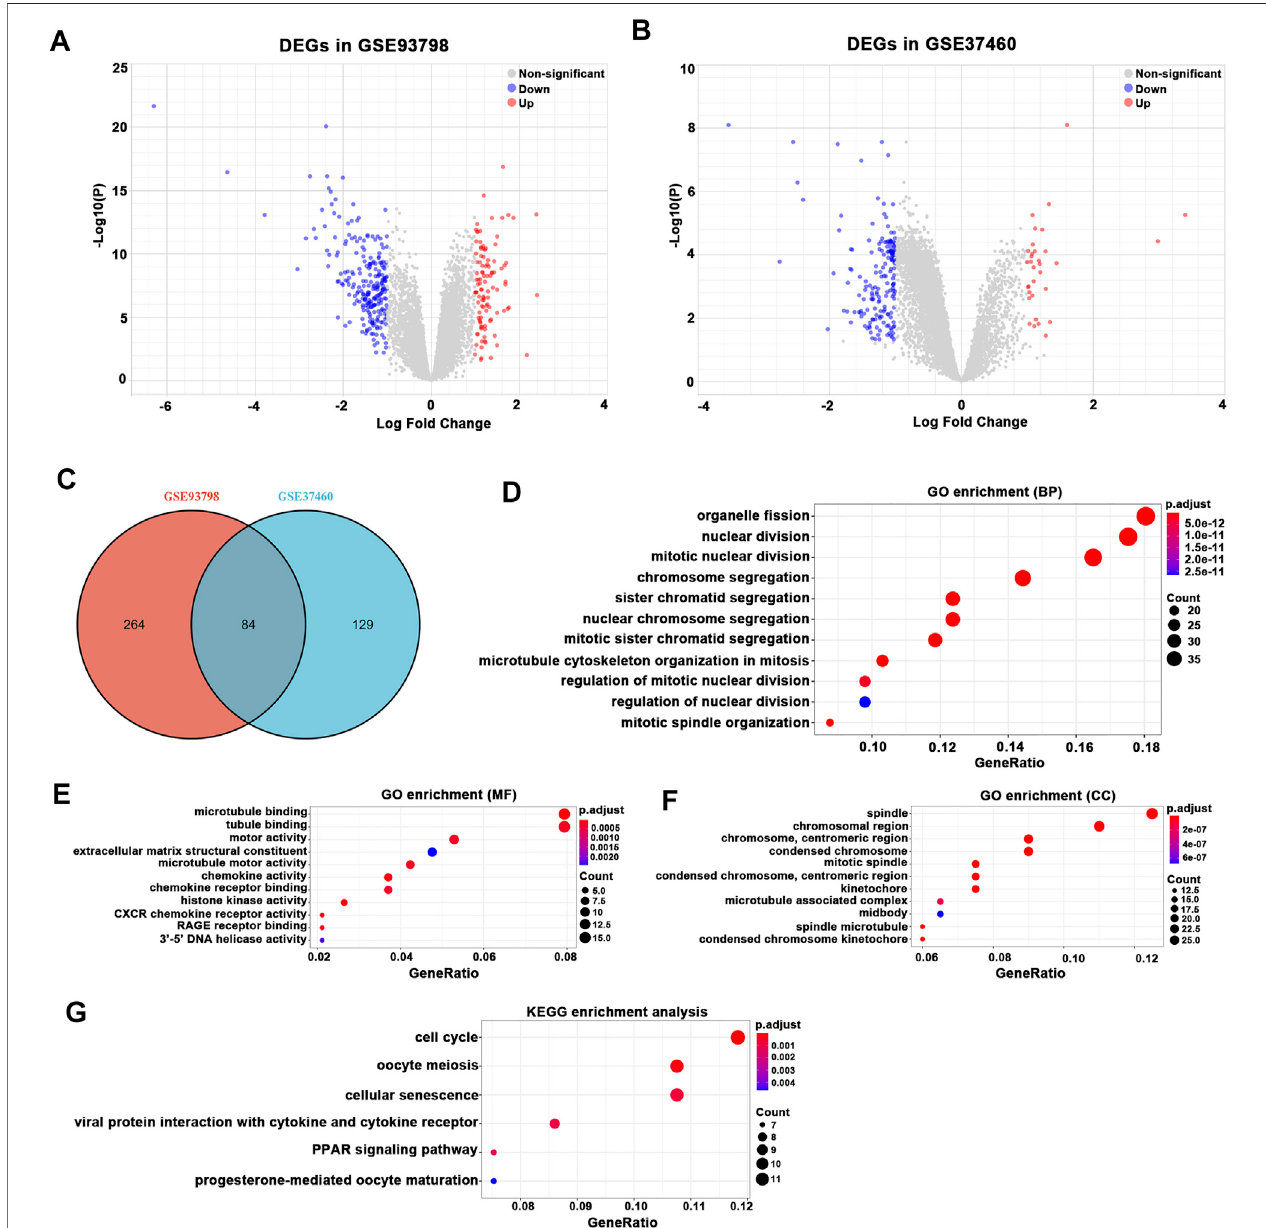
FIGURE 2 | Differentially expressed gene (DEG) expression between healthy living donor and IgAN. (A) In total, 348 DEGs (107 upregulated and 241 downregulated) in GSE93798 were selected by volcano plot fi ltering (adjusted p < 0.05 and |log2 (FC)| > 1). (B) In total, 213 DEGs (33 upregulated and 180 downregulated) in GSE37460 were selected by volcano plot fi ltering (adjusted p < 0.05 and |log2 (FC)| > 1). (C) In total, 84 overlapping DEGs (12 upregulated and 72 downregulated) between GSE93798 and GSE37460 as showed by the Venn plot. (D – F) GO analyses results of DEGs. (G) Pathway analyses results of DEGs.